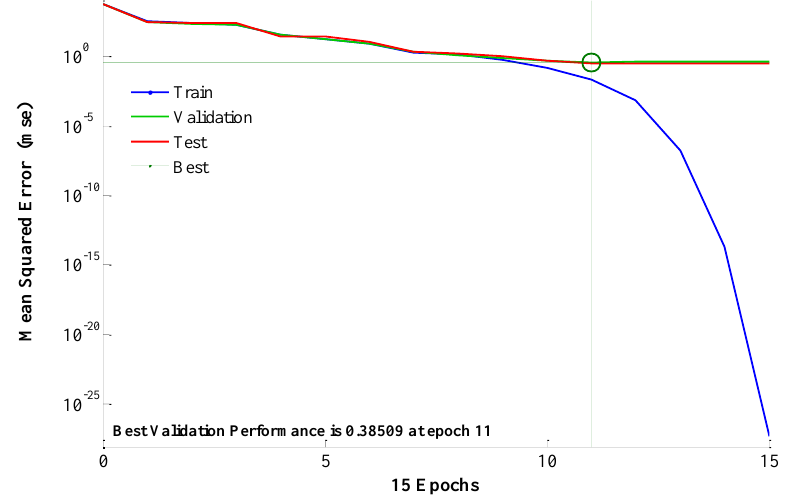
Figure 11. Network performance diagram for the predicted electrical conductivity of the nanofluids (the number of repetitions in terms of mean squared error).